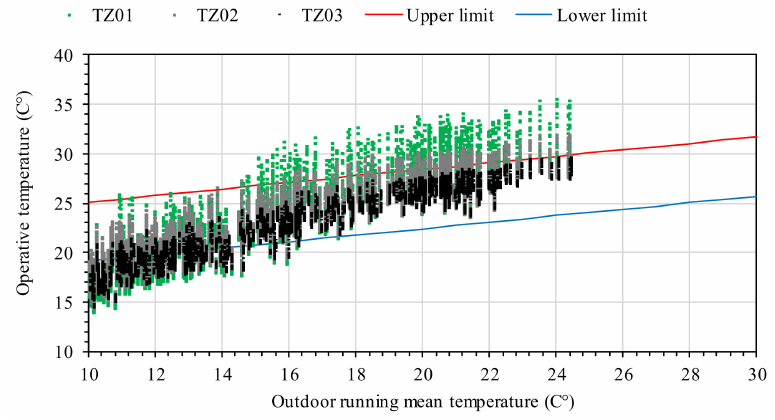
Figure 11. Thermal comfort analysis using EN16798-1 for the reference scenario.